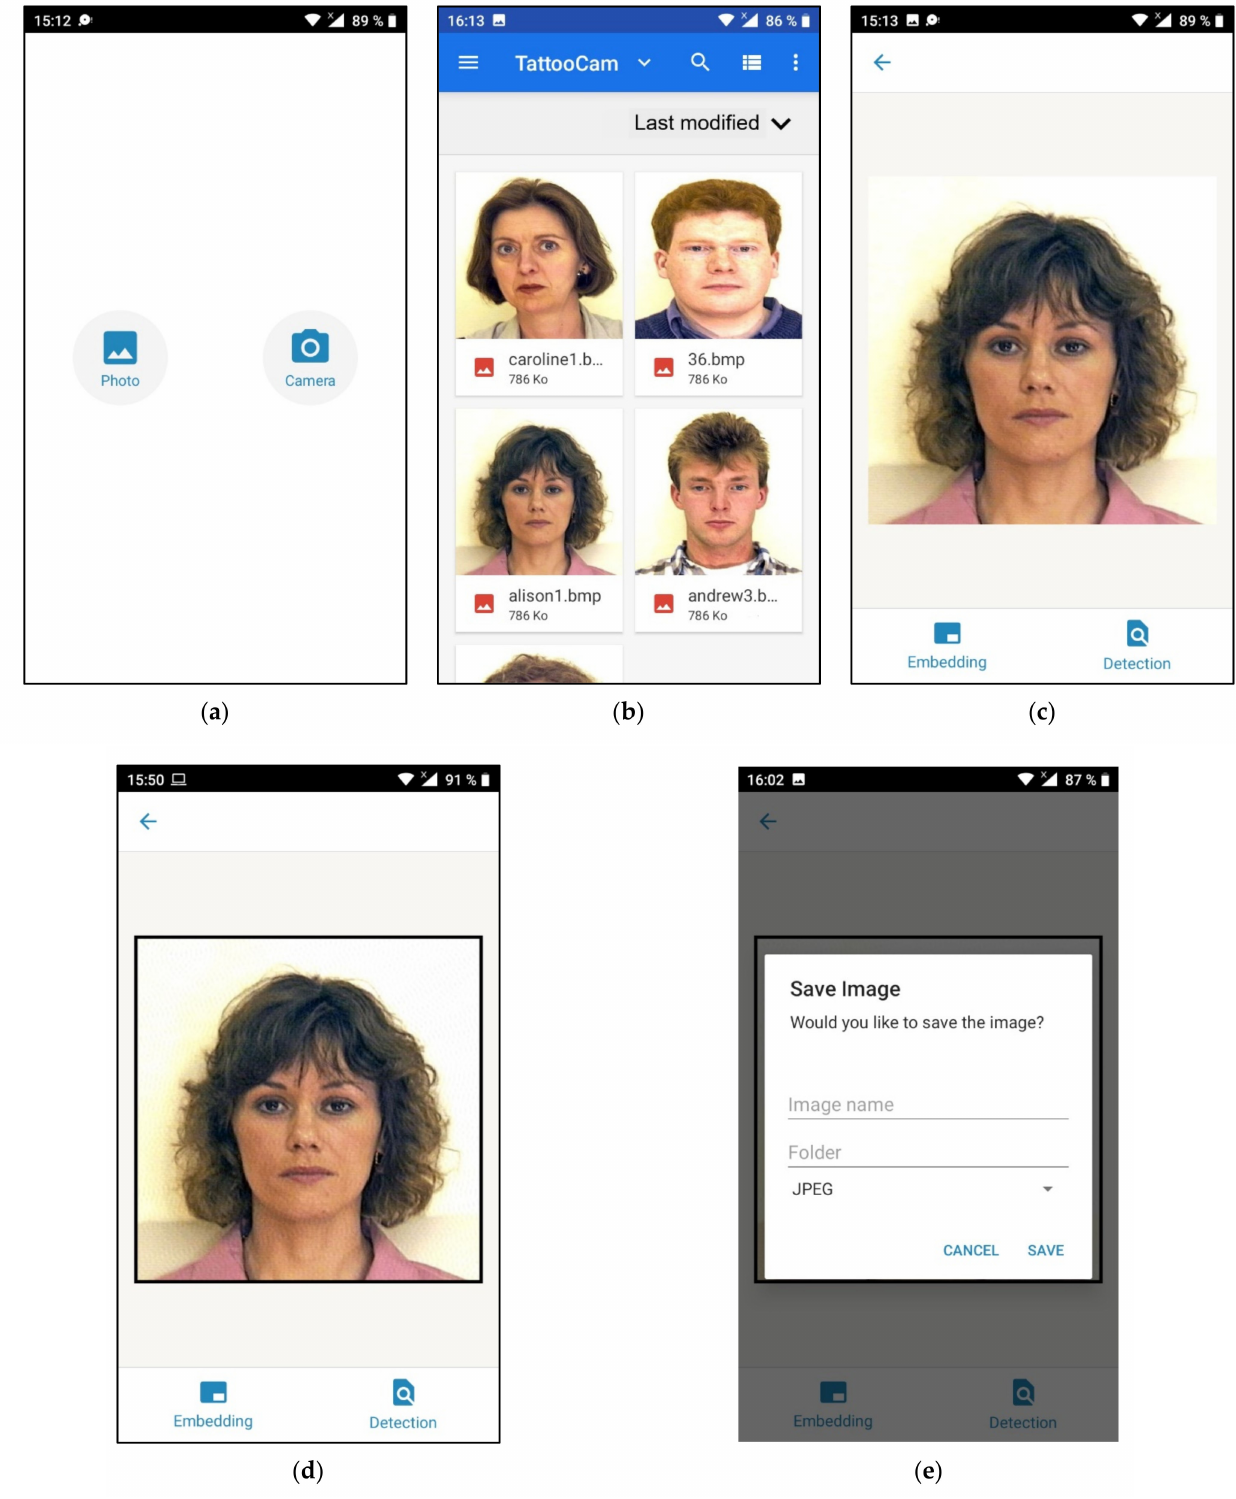
Figure 8. Watermark insertion process: ( a ) the main activity where the user can press the photo to access the gallery; ( b ) folder with the searched images; ( c ) the chosen image is displayed on other activity for watermark insertion; ( d ) after pressing the embedding key, the watermarked image is displayed on the screen with a frame; ( e ) action to name and save the new watermarked